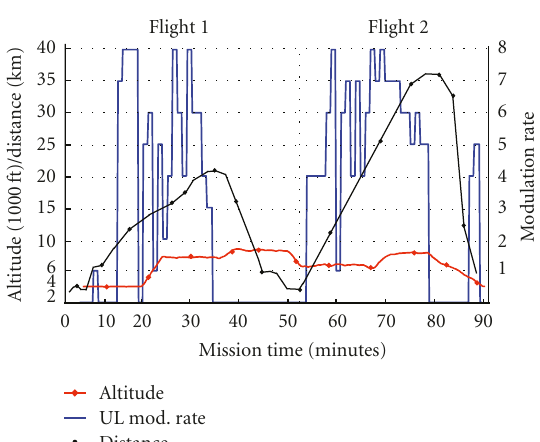
Figure 12: Helicopter flights: uplink rate, altitude and link distance versus